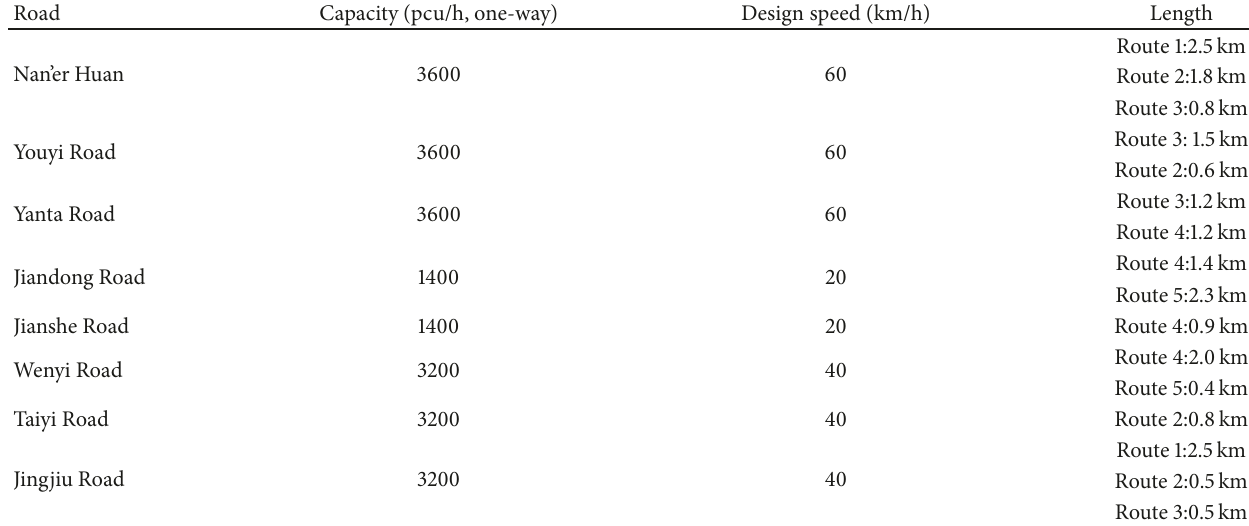
Table 1: Attributes of the roads.